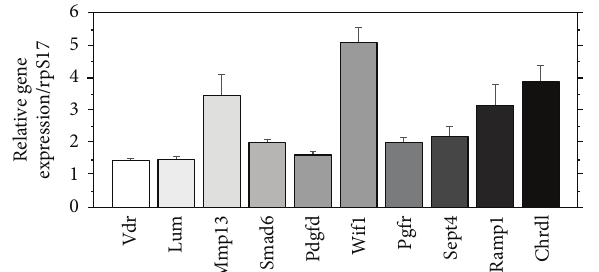
Figure 1: RT-PCR for 10 genes in relation to cell proliferation and differentiation. Each bar indicates the SD of triplicate